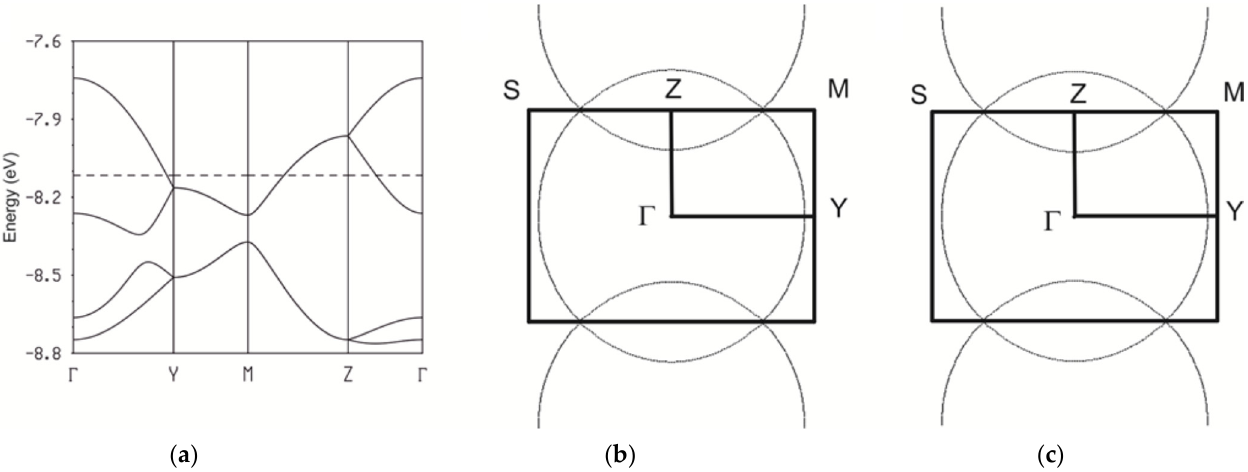
Figure 7. ( a ) Calculated band structure and ( b ) Fermi surface for the donor layers of κ -(BDH-TTP) 4 ReF 6 ( 1 ); ( c ) Fermi surface calculated for the donor layers of κ -(BDH-TTP) 4 ReF 6 ·4.8H 2 O ( 2 ). In (a) the dashed line refers to the Fermi level. Γ = (0, 0), Y = ( b* /2, 0), Z = (0, c* /2), M = ( b* /2, c* /2) and S = ( − b* /2, c* /2).